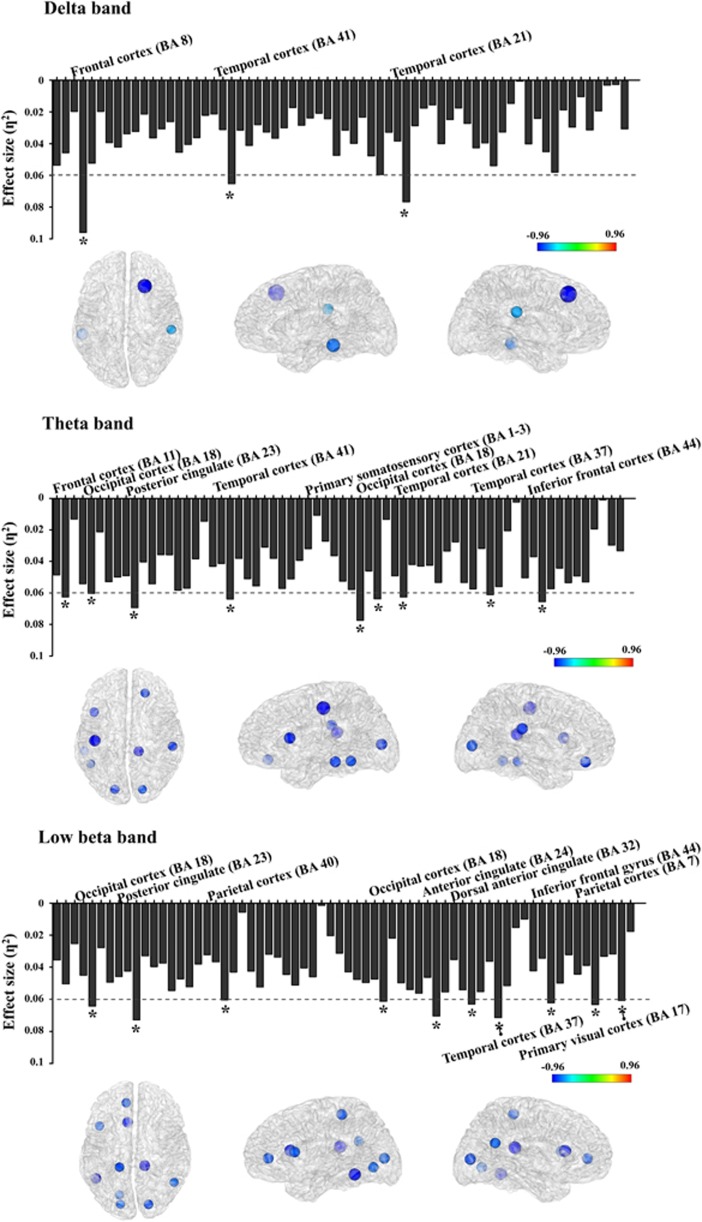
Effect-size of differences of nodal clustering coefficients between post-traumatic stress disorder (PTSD) and healthy controls (HCs) in three frequency bands. The threshold value was set as 0.06 (medium effect). In the brain model, the density of colors and size of circles represent the difference direction and effect-size, respectively. *η2>0.06.